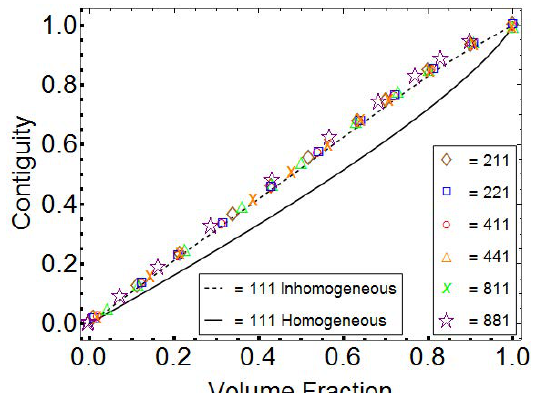
Figure 6. Contiguity against volume fraction. Solid line: the growth of spheres nucleated according to a homogeneous Poisson point process. Dashed line: the growth of spheres nucleated according to an inhomogeneous Poisson point process. The symbols correspond to ellipsoids nucleated according to an inhomogeneous Poisson point process